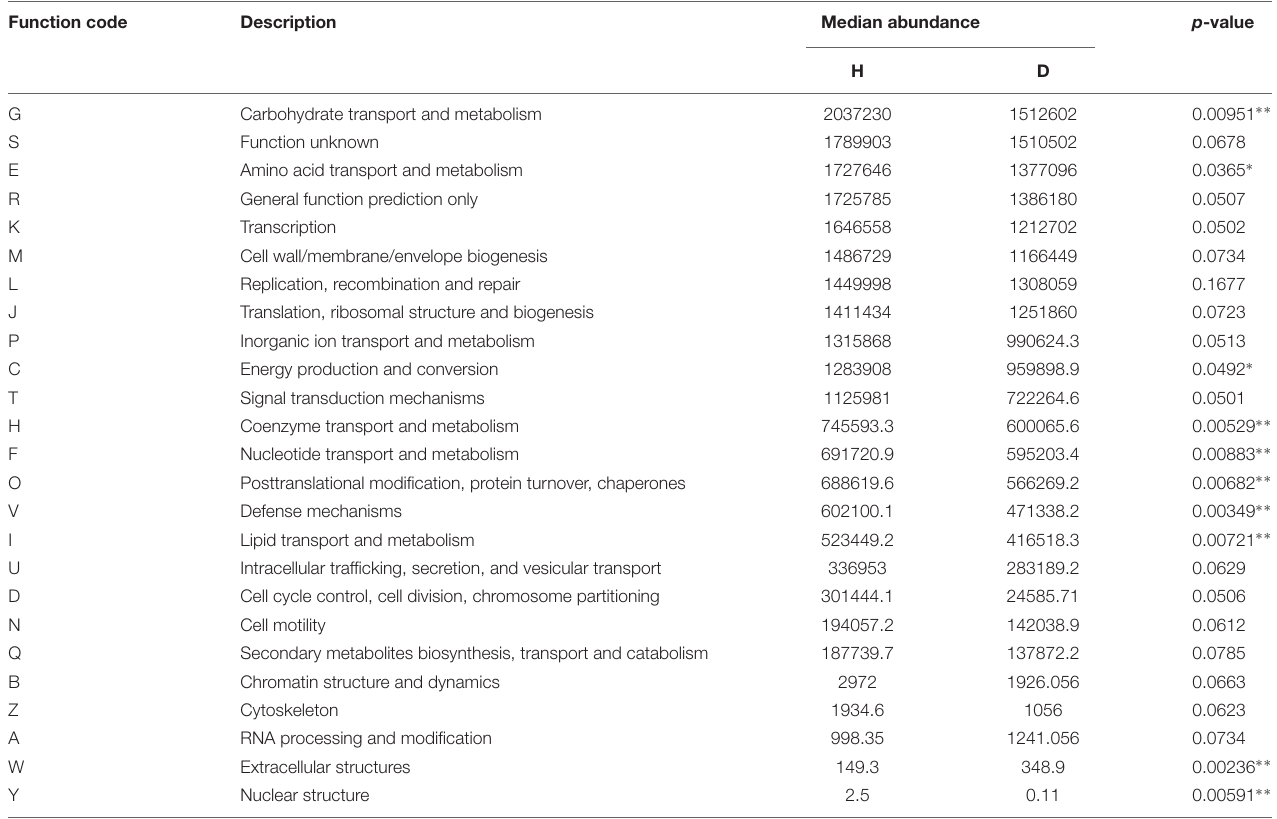
TABLE 3 | Comparisons of COG functional abundance between healthy (H) and diarrhea (D) groups. Function